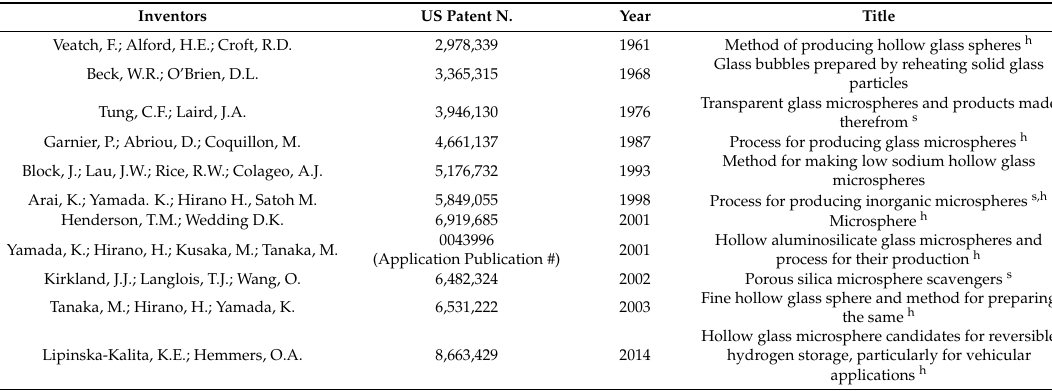
Table 1. List of United States Patents referring to the fabrication process of glass microspheres. The superscripts s,h indicate solid and hollow microspheres,